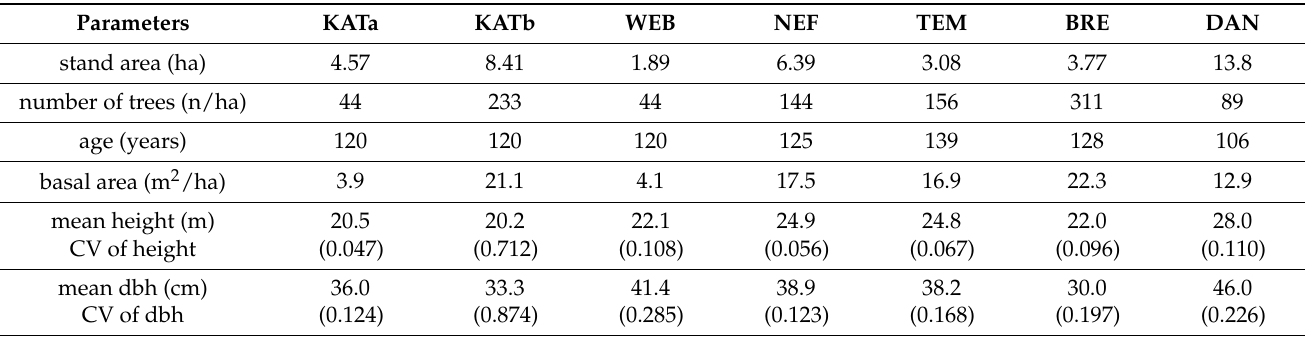
Table 1. Overview of the stands, overstorey pine trees, and the characteristics of the study sites. (The coefficients of variation (CV) are specified in brackets and the spatial patterns are characterised by the aggregation index according to Clark & Evans ( RCE